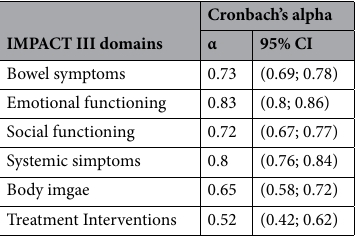
Table 2. Internal consistency. 95% CI 95% Confidence Interval.